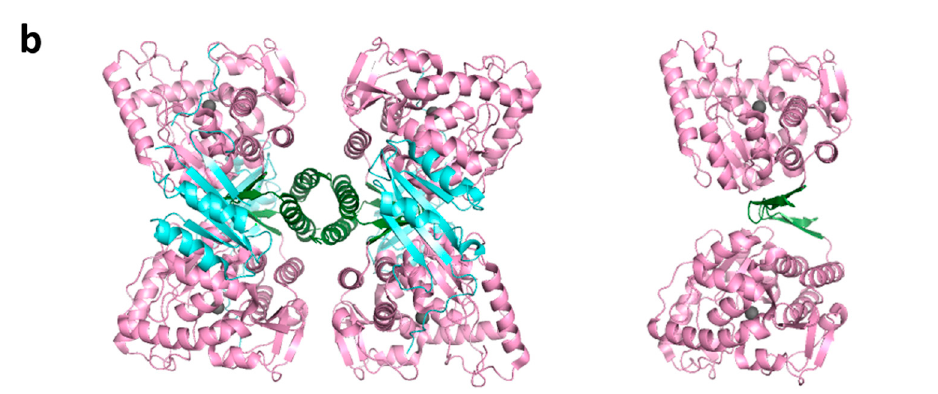
Figure 1. Human PAH domain structure and constructions used. ( a ) Schematic representation of the full-length PAH construction (residues Met 1-Lys 452, named PAHt) and of a double truncated form (residues Gly 103-Thr 427, named PAHd) with annotated structural and functional domains: regulatory domain (in aquamarine), catalytic domain (in light pink) and multimerization domain (in green). The truncated form, PAHd, lacks most of the regulatory and multimerization domains. ( b ) Structures of the two PAH constructions: tetrameric PAHt (left) and dimeric PAHd (right) forms using as templates the crystal structures of the full-length human PAH in the resting state (mutant C29S, PDB 6N1K) [13] and the double truncated human PAH form ( Δ N1-102/ Δ C428-452) (PDB 1J8T) [14]. Note that residues 103–117 are missing in the 1J8T PDB file.